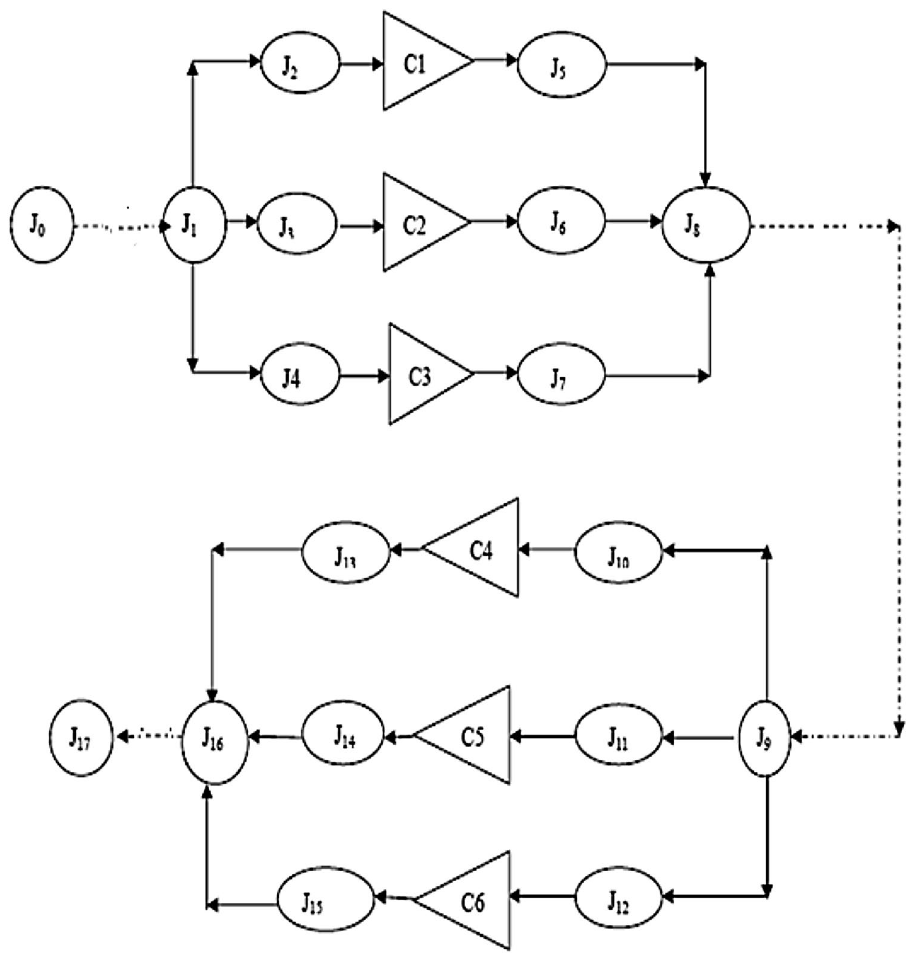
Fig. 1 Gas pipeline